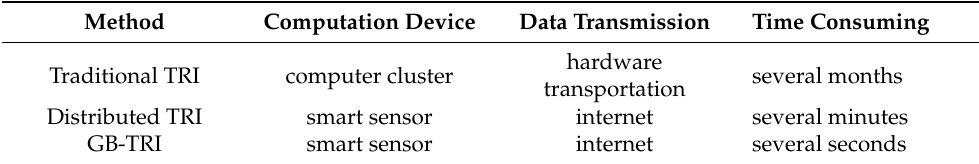
Table 1. A comparison of different microseismic localization methods.